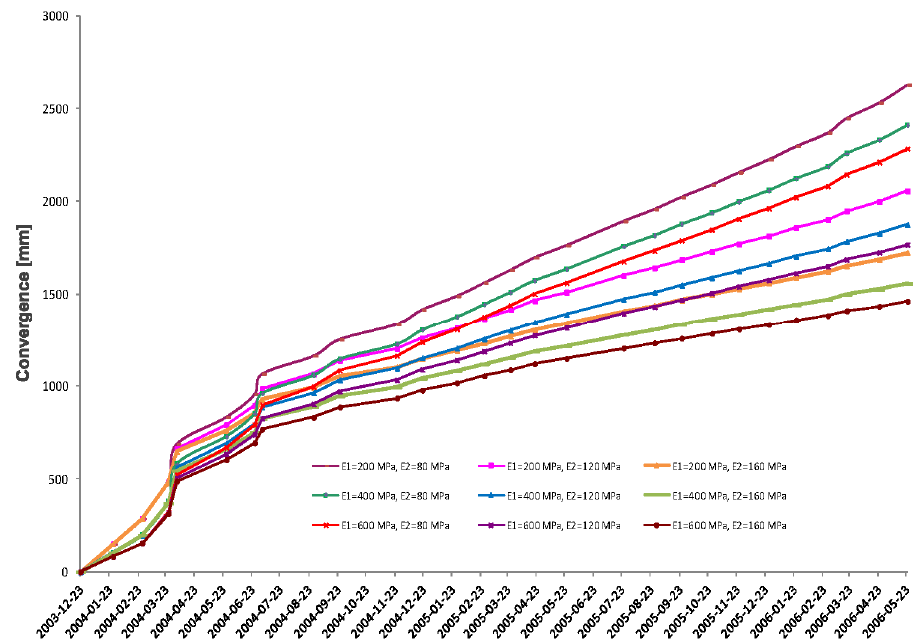
Figure 12. Results of convergence calculated numerically for the matrix of the experiment.